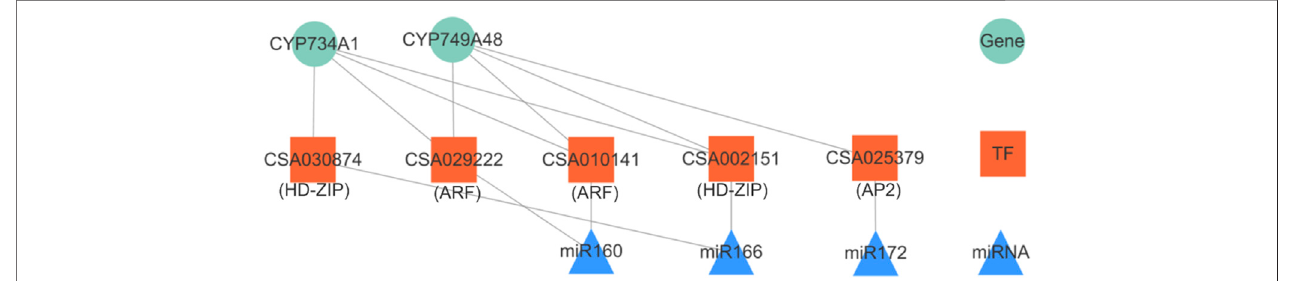
FIGURE 7 | miRNA – TF-target genes network in negative correlation modules. The upper triangle represents miRNAs, the middle square represents TFs, and the lowest circle represents target genes.